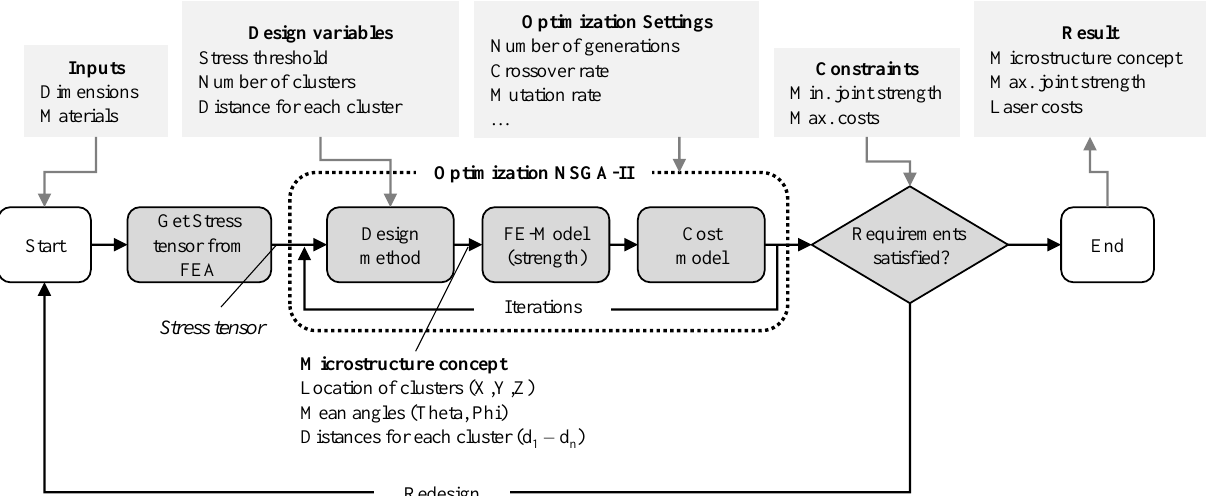
Figure 11. Optimization approach for the concept design of laser-based plastic–metal joints. With the given strength constraint, the costs shall then be minimized. The parameters stressThreshold and the distance for each cluster were used as design variables. Theoret- ically, the microstructure of each cluster (i.e., the geometry of the cavities) could also be varied through the number of laser runs. However, only the microstructure with six laser runs was used to limit the number of design variables and the initial optimization